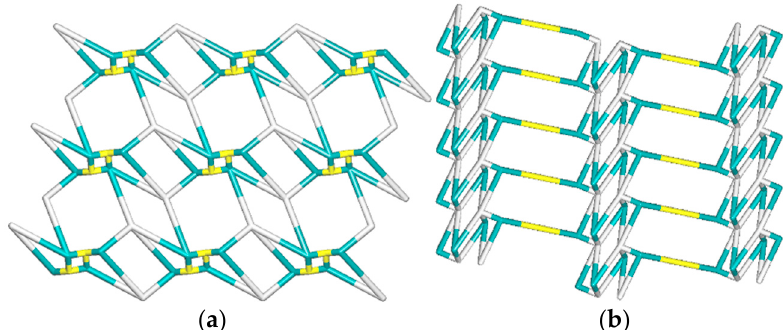
Figure 9. Topological representation of underlying nets: ( a ) 2D layer with 3,4L33 topology in 44 ; ( b ) trinodal 3,3,5-connected 2D layer in 45 with the unique topology and point symbol of (4.6 2 )(4 3 )(4 4 .6 4 .8 2 ). Adapted from [57].